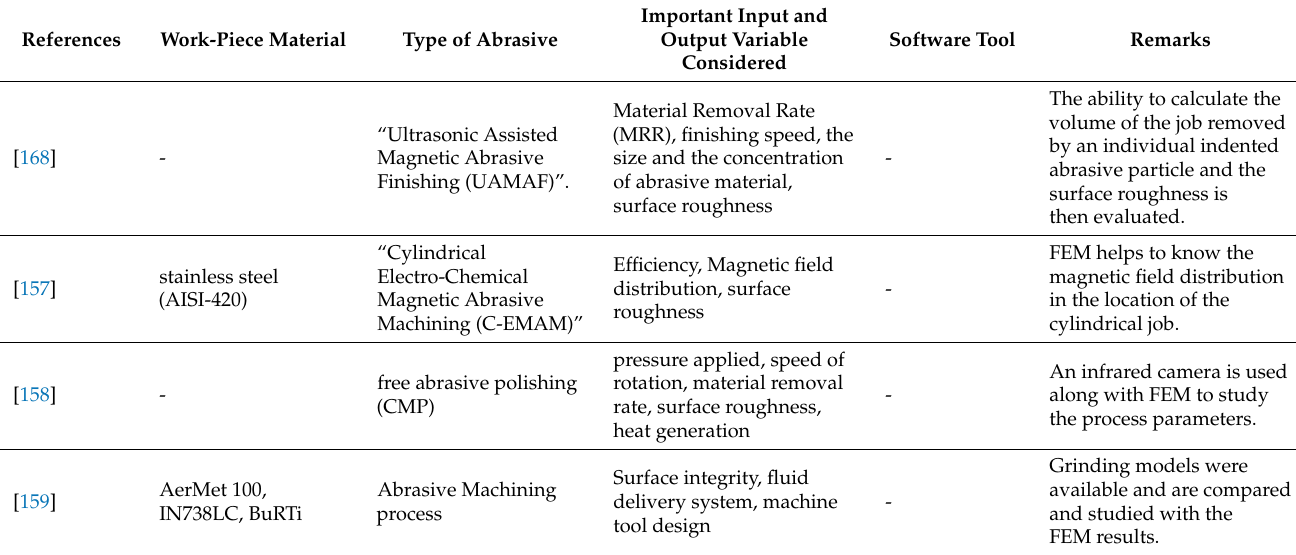
Figure 29. Discrete element method procedure.